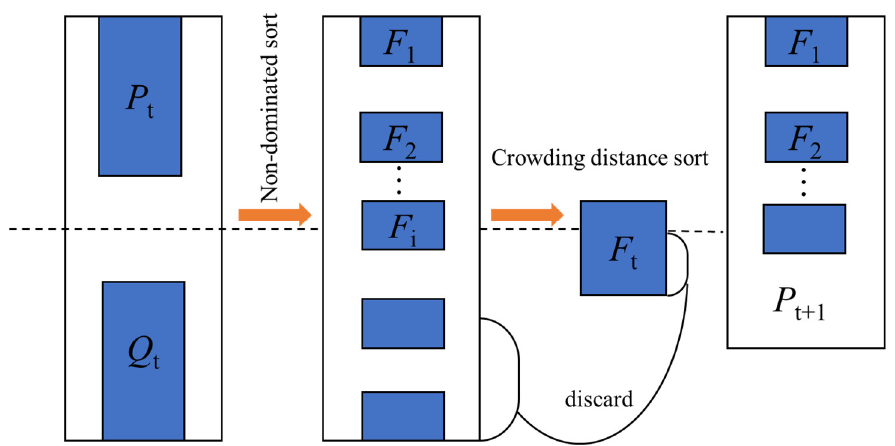
Figure 5. Flowchart for solving the Pareto solution set.